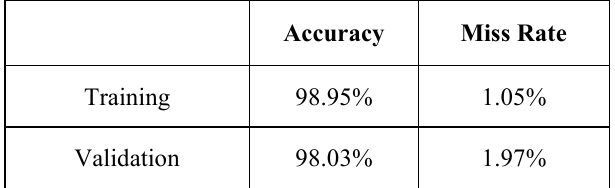
Table 3. Training and validation accuracy of the proposed TC2S- DNN model